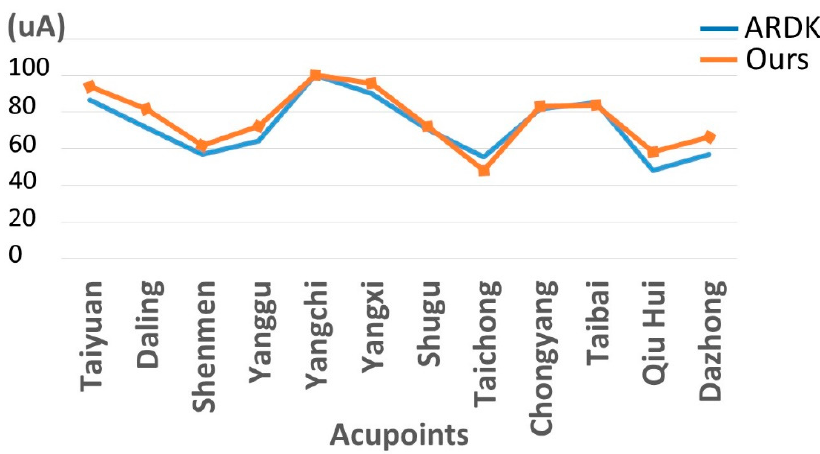
Figure 9. Comparison of the proposed GSR sensor with the Automatic Reflexodiagnostic Komplex (ARDK).